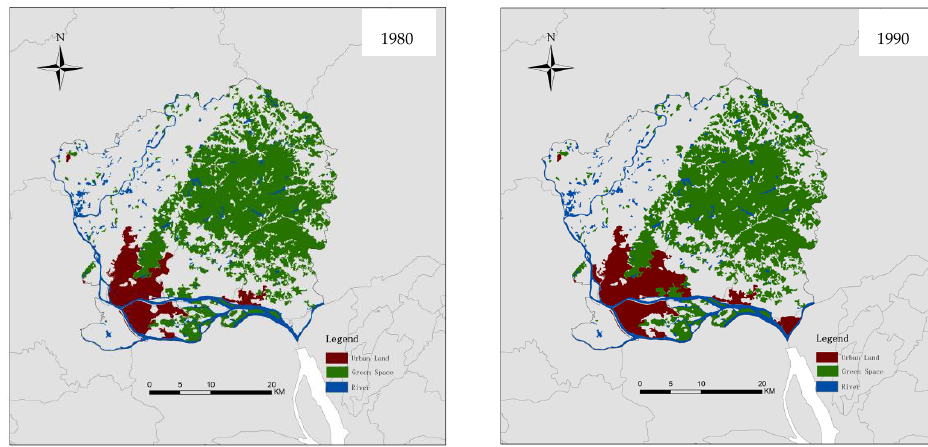
Figure 7. Urban expansion ratio between collective land and state land. (Source: drawn by the authors).